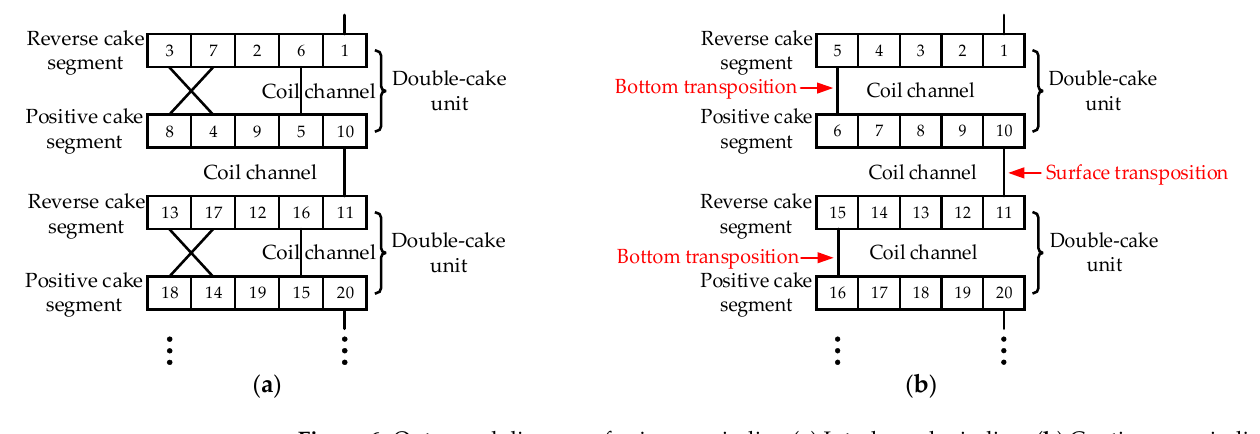
Figure 6. Outspread diagram of primary winding ( a ) Interleaved winding; ( b ) Continuous winding.